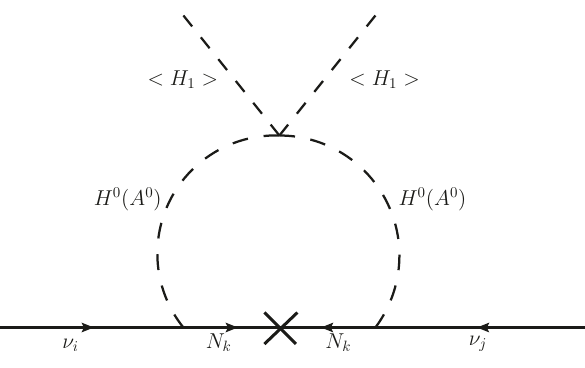
Figure 17 . One loop neutrino mass generation